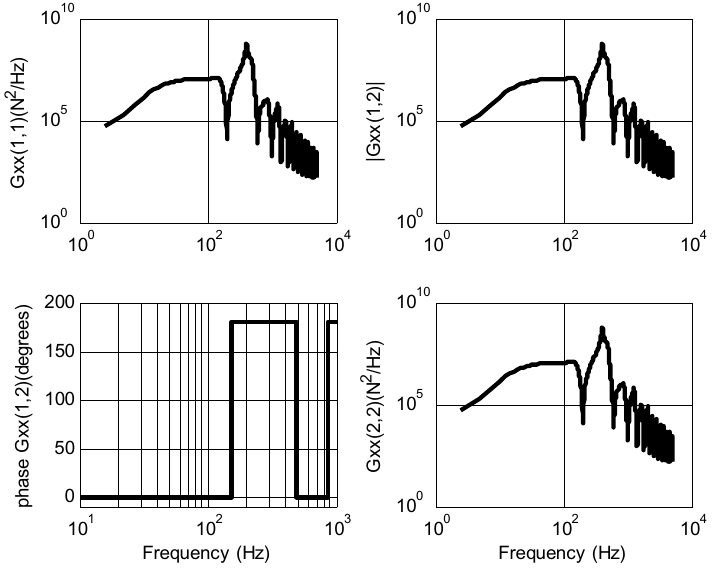
Fig. 25. Example 4, Magnitude of the Fourier spectra of the inputs, scaled as power